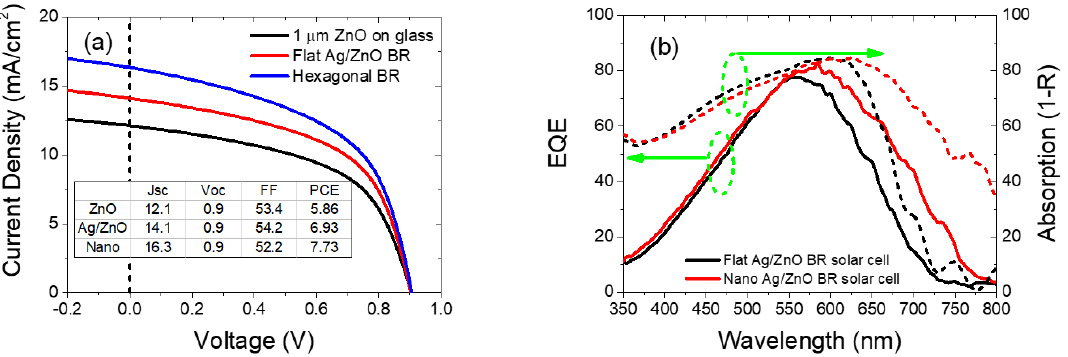
Figure 12. ( a ) Density-voltage ( J - V ) and solar cell parameters of different solar cells; ( b ) external quantum efficiency (EQE) and absorption (1 – R_total) of nanostructured and planar Ag/ZnO BR solar cells.